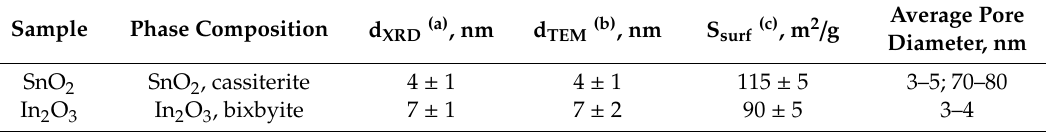
Table 1. Microstructure characteristics of synthesized semiconductor oxides.